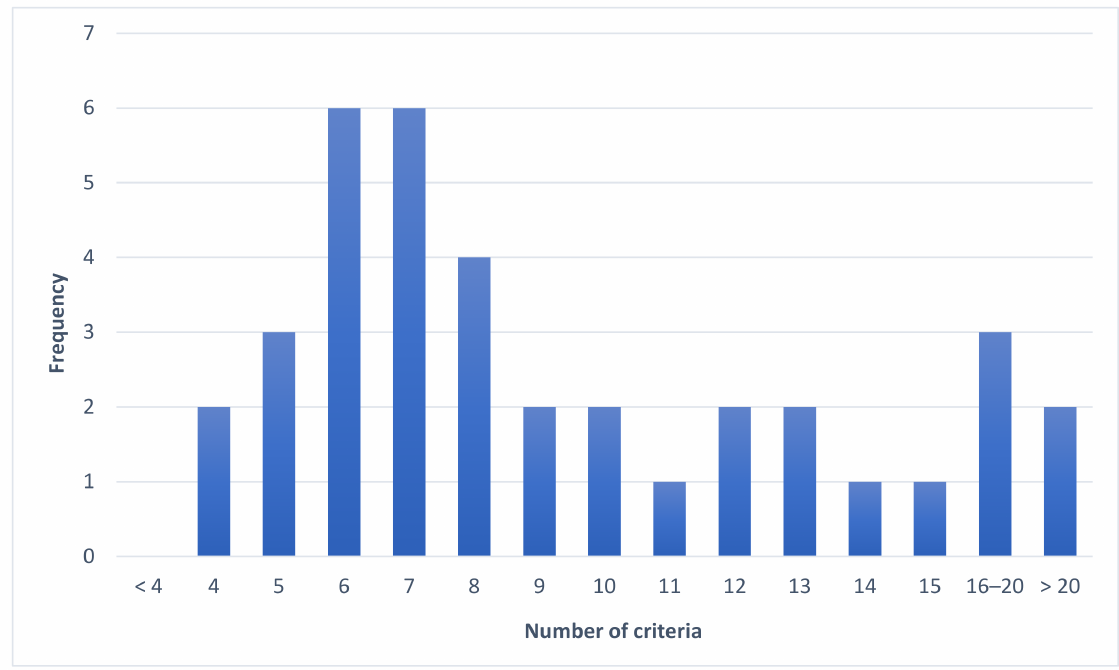
Figure 3. Distribution of the number of criteria in the reviewed